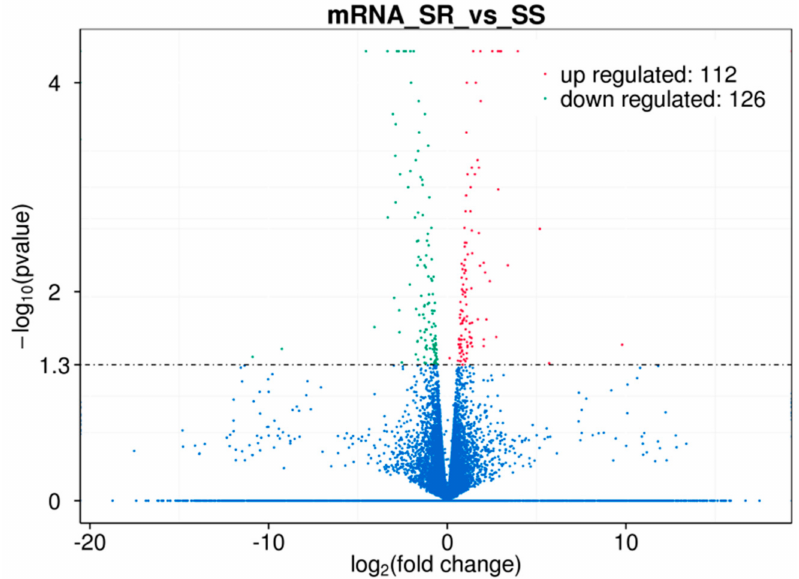
Figure 1. A volcano plot displaying the differentially expressed genes (DEGs) between the E. coli F18-resistant ( n = 3) and -sensitive groups ( n = 3) based on RNA-seq analysis. Red dots represent upregulated DEGs; green dots represent downregulated DEGs; blue dots represent non-DEGs; dotted line represents a screening threshold for DEGs; the x -axis values correspond to the log 2 (fold change) value; the y -axis corresponds to the mean expression value of the − log 10 ( p -value) between the E. coli F18 sensitive (SS) and E. coli F18 resistant (SR) groups (fold change =